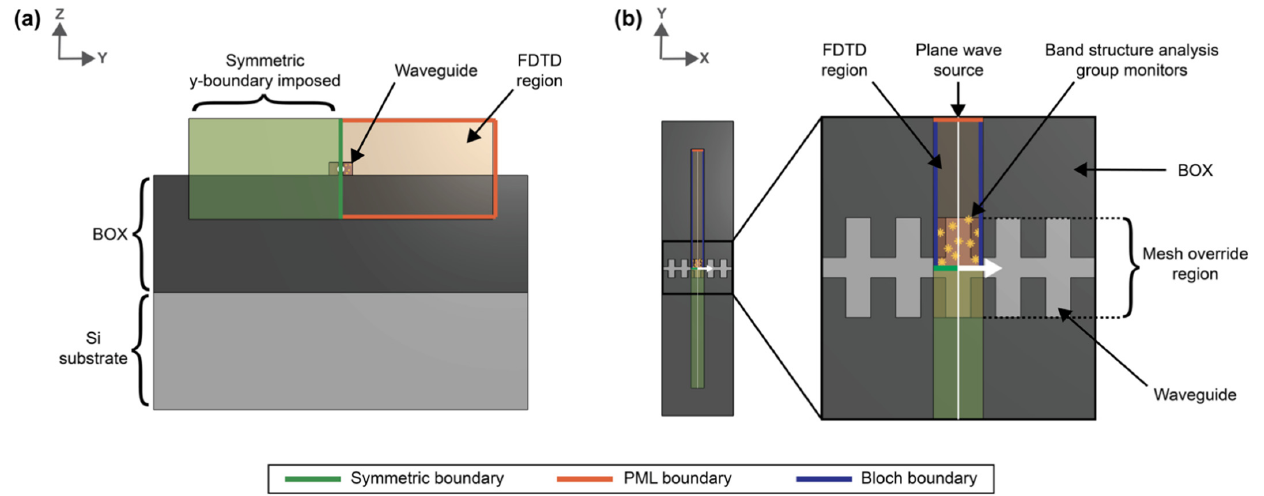
Figure 2. ( a ) Illustration of cross-section of finite difference time domain (FDTD) band structure simulation setup. ( b ) Illustration of top view of FDTD band structure simulation with magnified view of waveguide region.